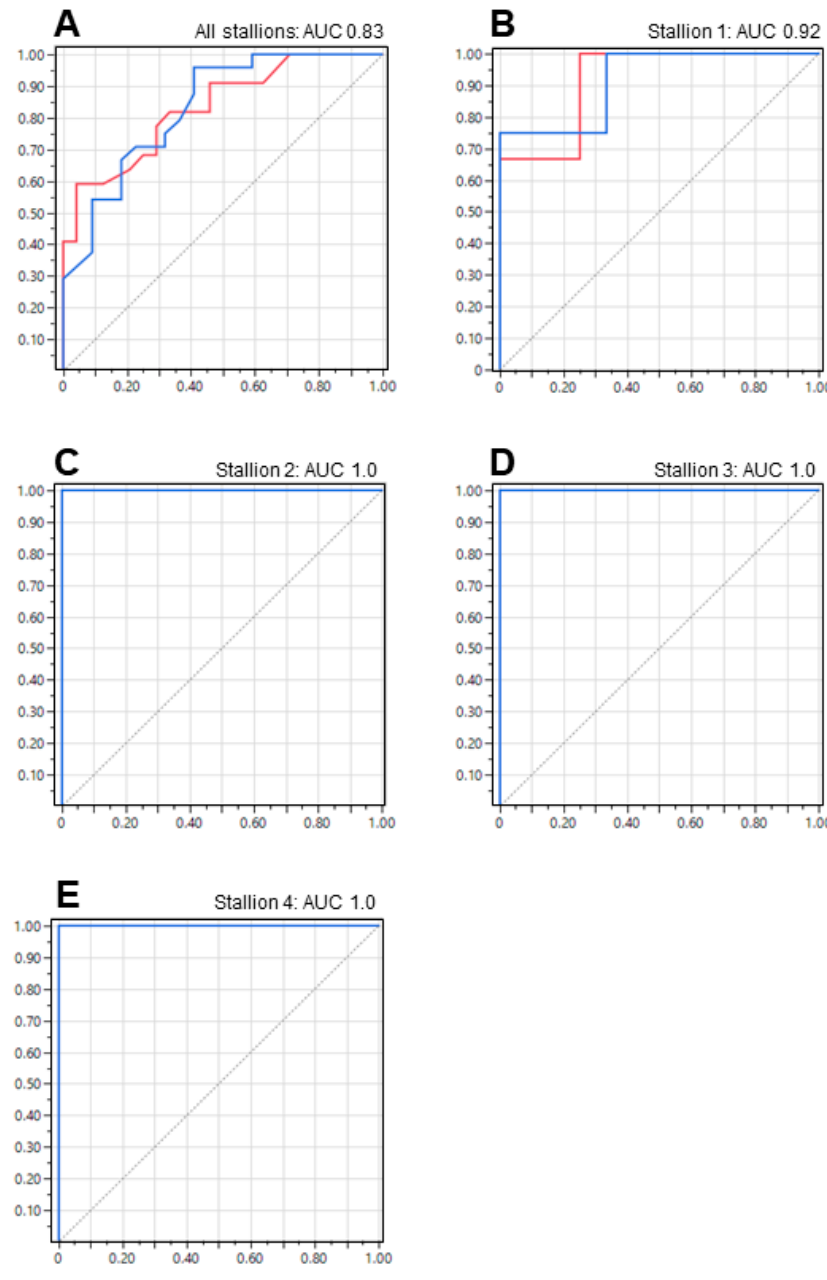
Figure 6. Receiver operating characteristic (ROC) curves were used to predict pregnancy based on stallion spermatozoa analyzed after chilling (post-chill), with the aim of achieving an Area Under the Curve (AUC) value as close to 1.0 as possible. ( A ) Prediction of fertility by inclusion of all stallions generated a high AUC value of 0.83. This result was only limited to individual variation of fertility between stallions. If the analyses were optimized to individual stallions, then AUC values in excess of 0.92 ( B – E ) were routinely obtained, suggesting a very high level of predictive accuracy.